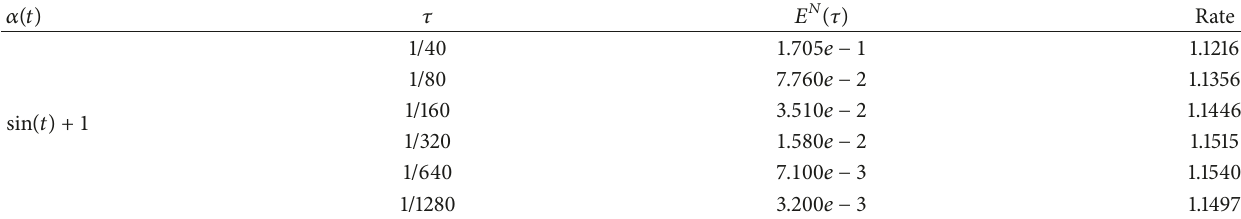
Table 9: Maximum errors and convergence rates for Example 2 at 𝑇 = 1 and 𝜎 6 = 𝜎 − 0.3